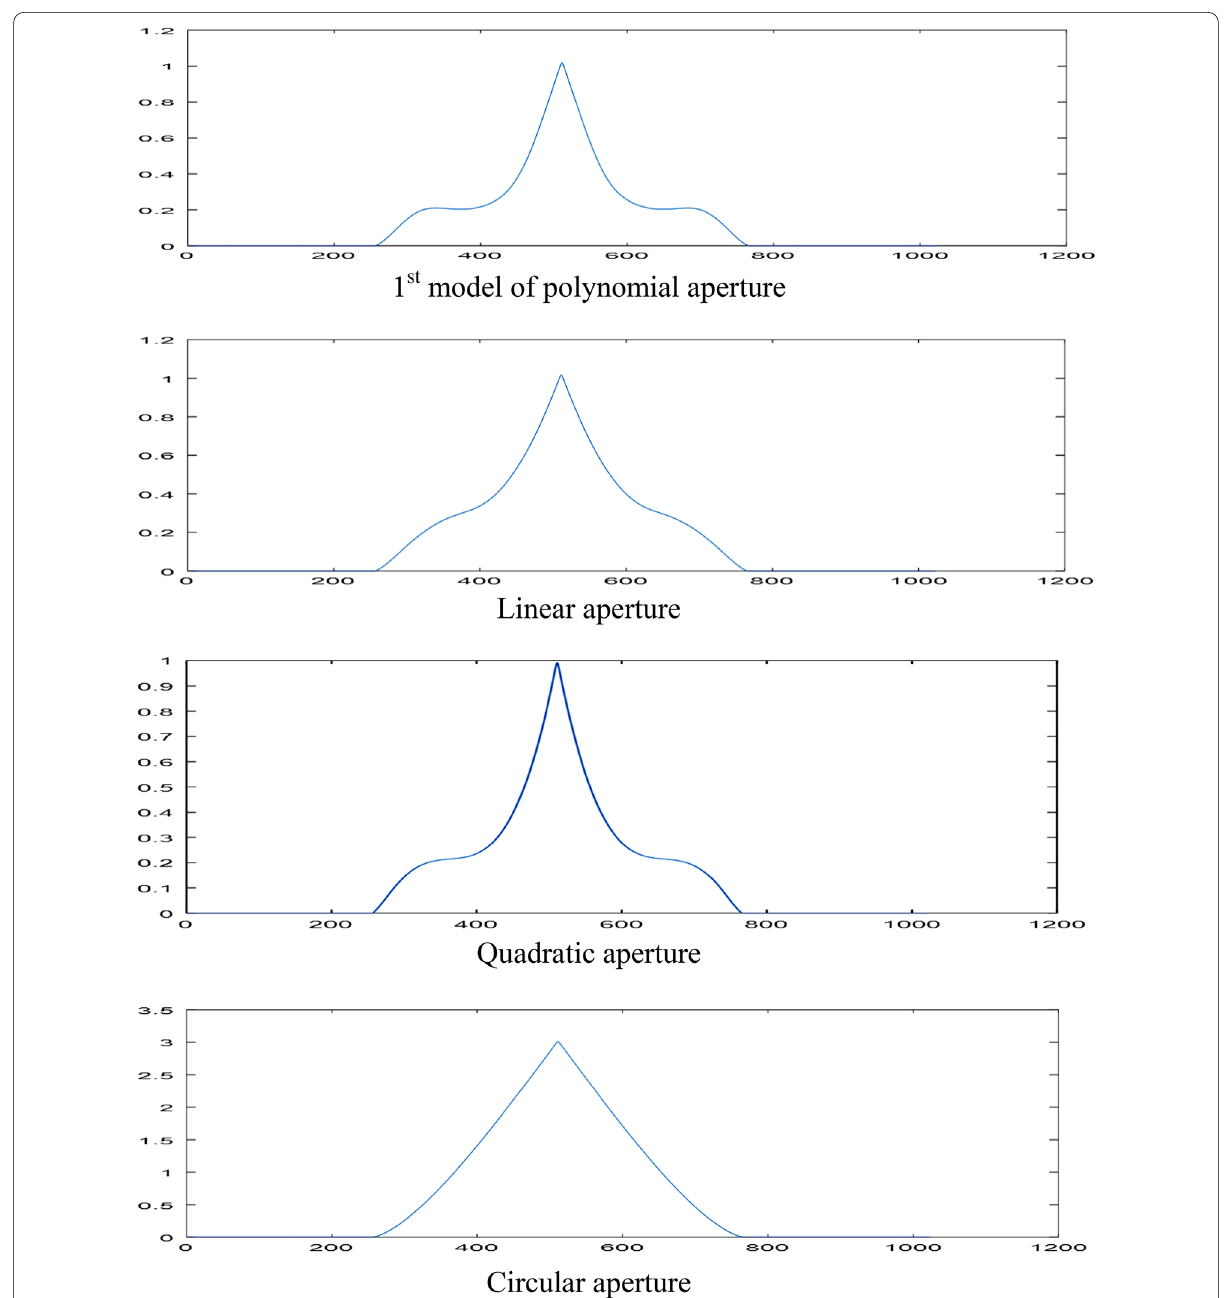
Fig. 9 Normalized autocorrelation for the first model of polynomial, linear, quadratic, and circular apertures